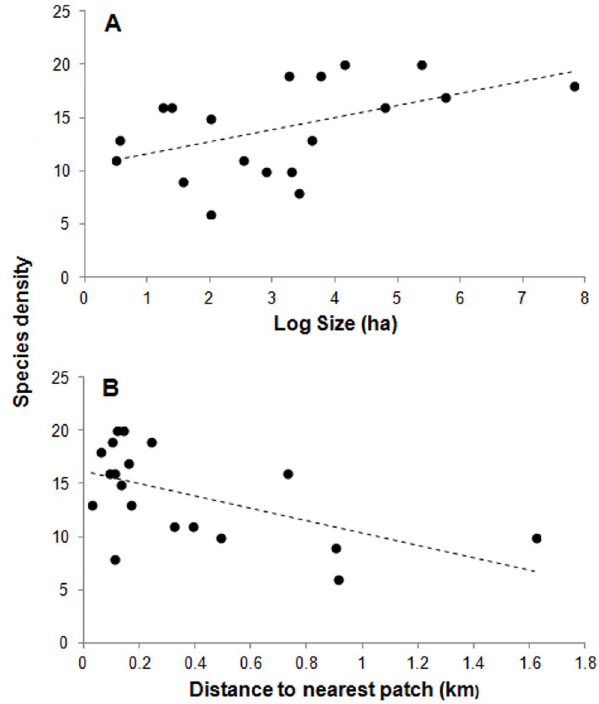
Figure 2. Relationship between plant species density (number of species in 0.1 ha) and patch size (Size) (A) and between plant species density and the distance to the nearest patch (B) for a group of 19 forest patches on the Yucatan Peninsula. Regression lines for A and B are also shown. The scale on the ‘‘x’’ axis for A is